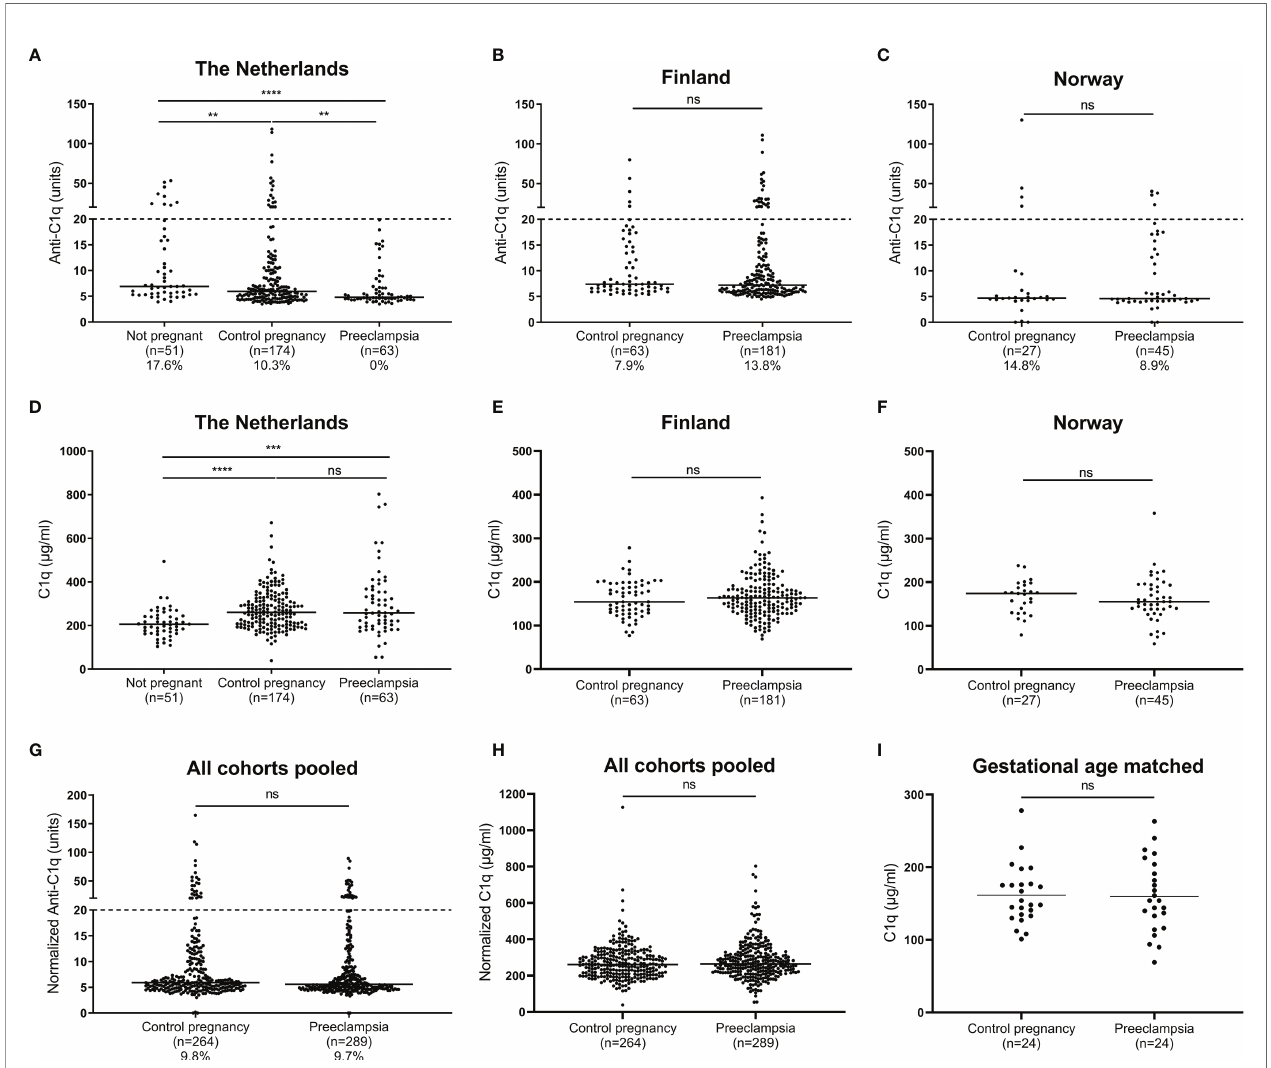
FIGURE 1 | Anti-C1q antibodies and C1q in healthy or PE pregnancy. Anti-C1q antibodies measured in maternal serum in cohorts from the Netherlands (A) , Finland (B) and Norway (C) , with percentages under the graph indicating the proportion samples deemed anti-C1q positive (>20 units, also indicated by dashed line). C1q concentration measured in maternal serum in cohorts from the Netherlands (D) , Finland (E) and Norway (F) . Data from different cohorts was normalized and pooled for anti-C1q (G) and C1q (H) . For the cohort from Finland, a subanalysis with samples matched for gestational age was additionally performed (I) . Comparisons tested by Mann-Whitney, or paired t test for panel I; ns, not signi fi cant (p > 0.05); **, 0.001 < p < 0.01; ***, 0.0001 < p < 0.001; ****, p <